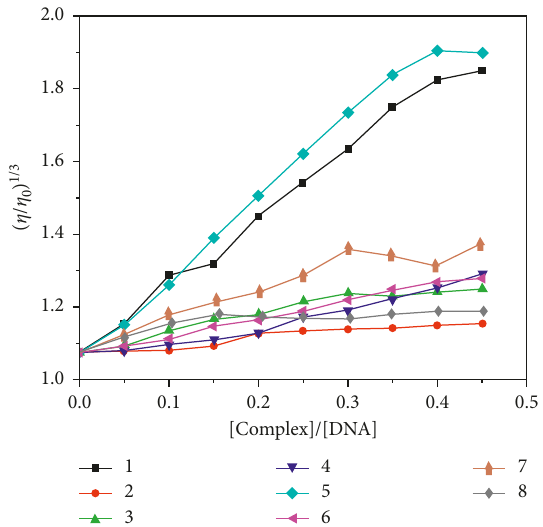
Figure 2: Effects of increasing amounts of heterocyclic Schiff base derivatives ( 1 – 8 ) on the relative viscosity of DNA at pH 7.4 and 25 ° C; [DNA] � 5.5 × 10 − 5 M and [compound] � 0.5–2.5 × 10 − 4